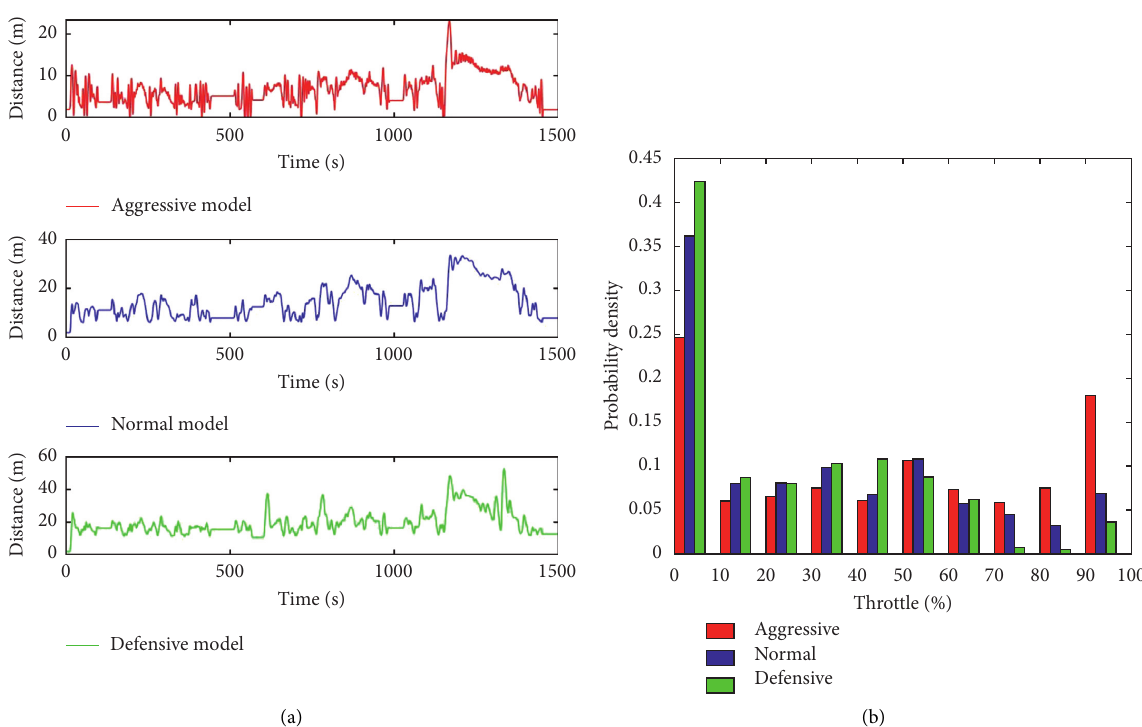
Figure 10: Driving style comparison. (a) Headway distance. (b) Throttle pedal